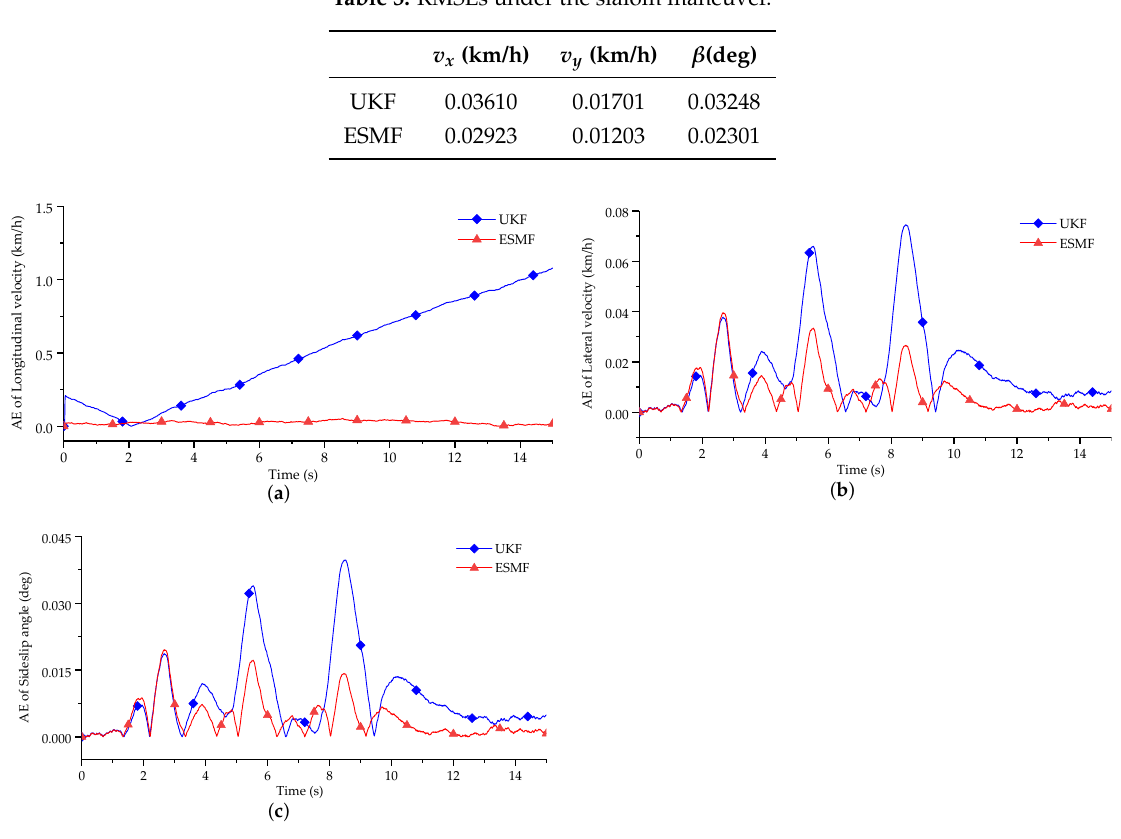
Table 3. RMSEs under the slalom maneuver.